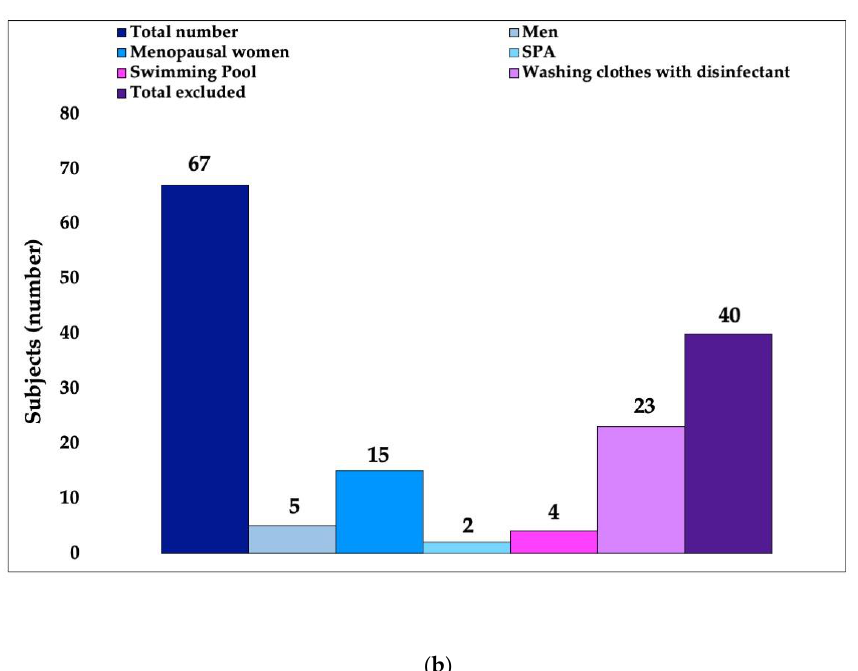
Figure 3. Results from first phase of study concerning the selection of volunteers on the base of a specific questionnaire: ( a ) based on primary criteria from 229 volunteers, 162 people were excluded; ( b ) based on secondary criteria starting from 67 volunteers, 40 subjects were excluded; thus, 27 women were chosen.